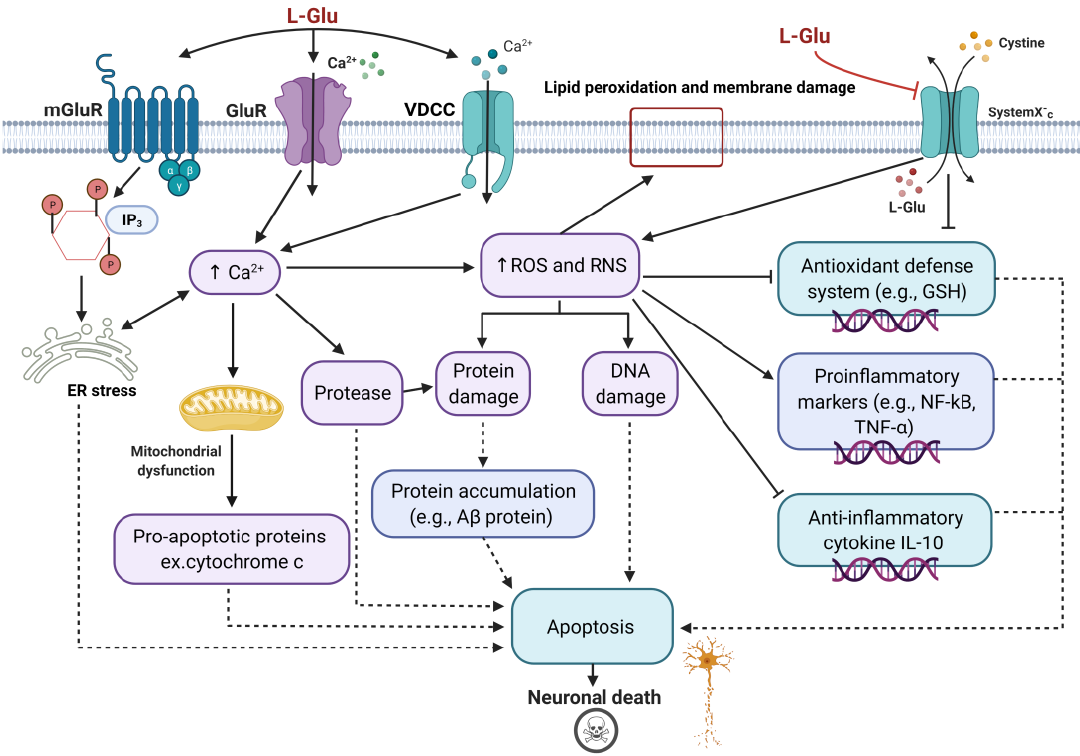
Figure 2. Schematic summary of the molecular mechanisms of L-Glu neurotoxicity. The binding of L-glutamate (L-Glu) to L-glutamate receptors (GluR) opens receptor channels, resulting in calcium ion (Ca 2+ ) influx. L-Glu also causes voltage-dependent Ca 2+ channels (VDCCs) to open and further Ca 2+ influx. L-Glu activation of metabotropic glutamate receptors (mGluRs) results in increased inositol triphosphate (IP 3 ) synthesis, triggering Ca 2+ release from endoplasmic reticulum (ER) stores. Collectively, a pathological level of Ca 2+ ions triggers ER impairment and Ca 2+ -dependent protease activation, which contributes to cellular protein damage and mitochondrial dysfunction, and neuronal apoptosis. High Ca 2+ accumulation in neurons also leads to the generation of reactive oxygen species (ROS) and reactive nitrogen species (RNS). L-Glu inhibits the glutamate/cystine antiporter system Xc- (system Xc-), resulting in cystine depletion, an essential element for the production of the cellular antioxidant, glutathione (GSH). This impairs the endogenous antioxidant defence system and further induces redox stress. ROS and RNS cause lipid peroxidation, protein, and deoxyribonucleic acid (DNA) damage and induce the production of markers of inflammation such as nuclear factor kappa- light-chain-enhancer of activated B cell (NF-kB) activation, production of tumour necrosis factor- α (TNF- α ), and inhibition of the production of the anti-inflammatory cytokine, interleukin 10 (IL-10), which collectively contributes to neuroinflammation and neuronal death. Protein modification and damage can also result in the accumulation of toxic proteins, such as amyloid beta (A β